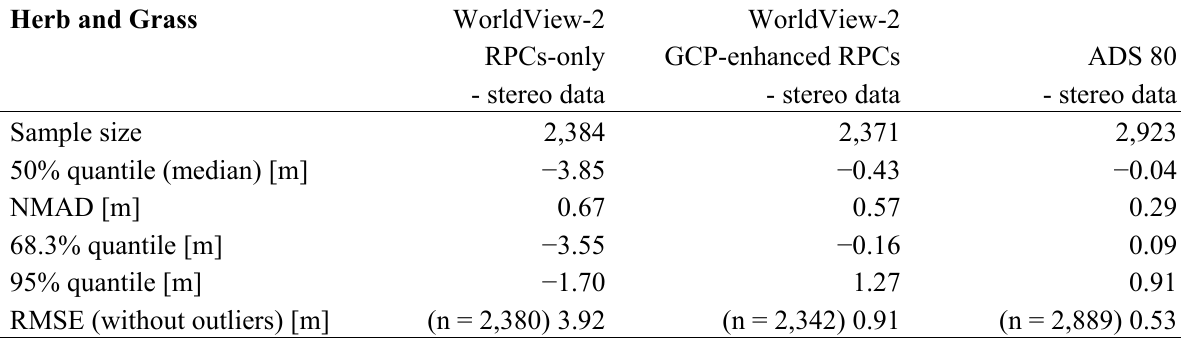
Table 4. Herb and grass vegetation. Vertical agreement measures of the three digital surface models in comparison with the